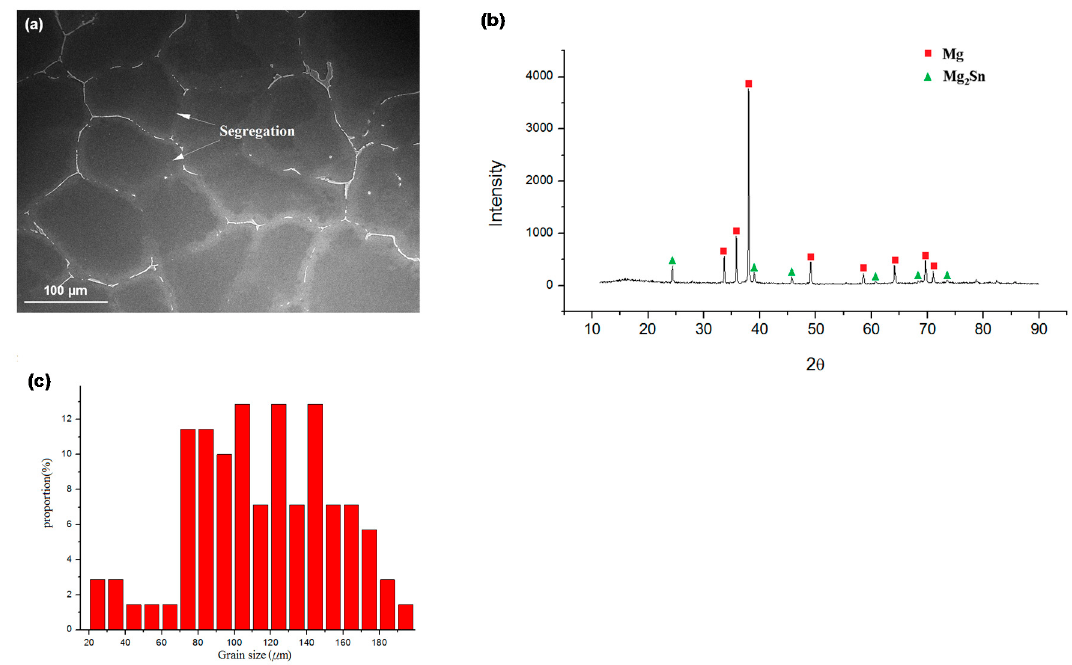
Figure 1. ( a ) Microstructure of the as-cast Mg-Sn alloy; ( b ) XRD spectrum of the as-cast Mg-Sn alloy; ( c ) grain size distribution of the as-cast Mg-Sn alloy calculated from the microstructure image.